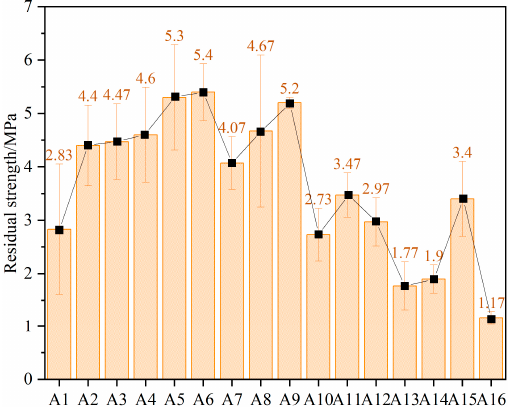
Figure 7. Residual strength of 16 test groups.